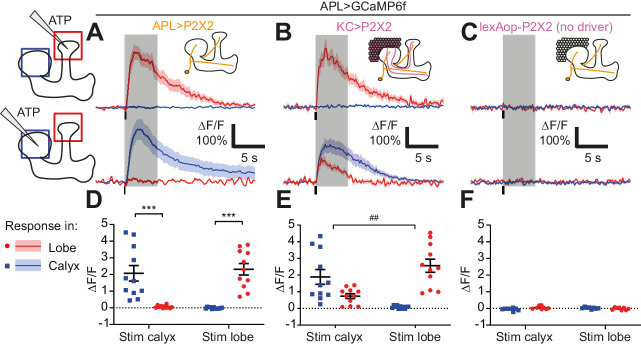
Activity in the APL neuron is spatially restricted.(A–C) Response of APL in the vertical lobe (red) or calyx (blue) to pressure ejection of 1.5 mM ATP (100 ms pulse, 12.5 psi) in the lobe or calyx, to stimulate APL (A), KCs (B), or negative control flies with lexAop-P2X2 but no LexA driver (C). Schematics show ROIs where responses were quantified (red/blue squares), and where ATP was applied (pipette symbol). Traces show mean ± SEM shading. Vertical lines on traces show time of ATP application; gray shading shows 5 s used to quantify response in (D–F). GCaMP6f and/or P2X2 expressed in APL via intersection of NP2631-GAL4 and GH146-FLP. P2X2 expressed in KCs via mb247-LexA. See Supplementary file 1 for full genotypes. (D–F) Mean ∆F/F from (A–C), when stimulating APL (D), KCs (E), or negative controls (F). Error bars show SEM. n, given as # neurons (# flies): (A,D): 11 (9); (B,E): 11 (7); (C,F) 8 (4). ***p<0.001, t-tests with Holm Sidak multiple comparisons correction. ## p=0.004, paired t-test: the ratio of (response in unstimulated site)/(response in stimulated) site is higher for calyx stimulation than lobe stimulation.Figure 4—source data 1.Source data for Figure 4D–F.